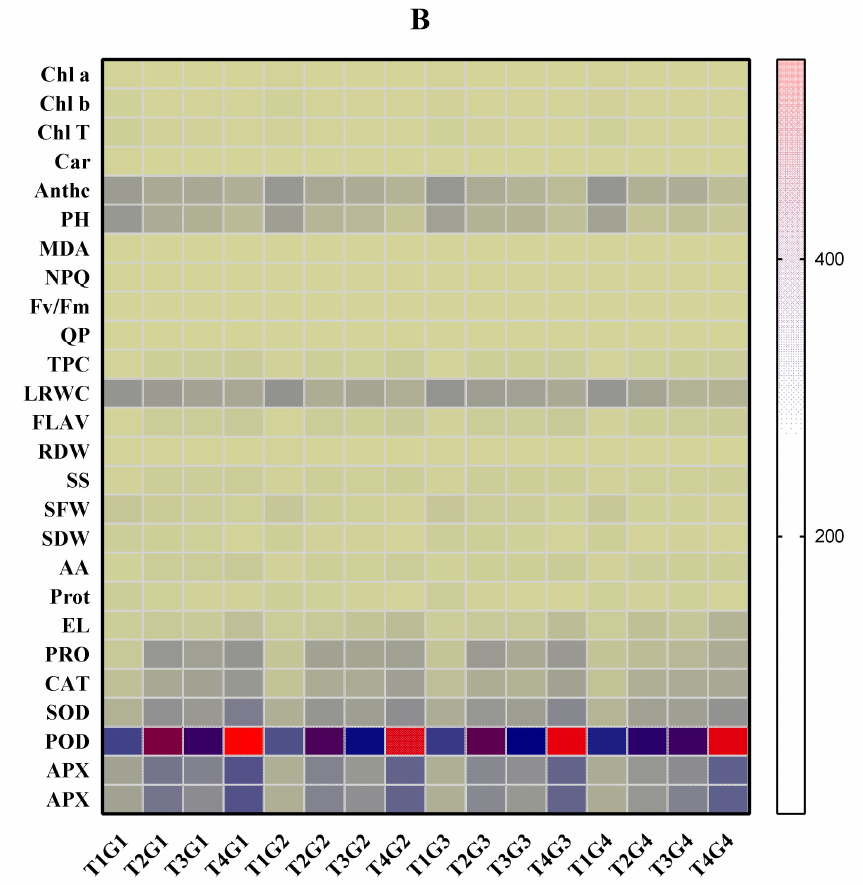
Figure 9. Multivariate statistical analysis indicates associations between treatments, variables, and cultivars. ( A ) Principal component analysis (PCA) based on eco-physiological traits in four soybean cultivars affected by drought, salinity, and combined stress. Blue circles, PI567731; green symbols, PI416937; red symbols, PI567690; and purple symbols, PI408105A in control, drought, salinity, and drought + salinity treatments; ( B ) Heatmap of correlation. T1, control: T2, drought: T3 salinity: T4 drought + salinity; G1, PI567731: G2, PI416937: G3, PI567690: G4, PI408105A. Chl: chlorophyll; Car: carotenoids Chl T: total chlorophyll; PH; plant height; SFW: shoot fresh weight: SDW: shoot dry weight: QP: photochemical quenching; NPQ: non-photochemical quenching; maximal photochemical efficiency (Fv/Fm), RLWC: relative leaf water content; MDA: malondialdehyde; EL: electrolyte leakage; PRO: proline; SS: soluble sugar; CAT: catalase; POD: peroxidase; SOD: superoxide dismutase; APX: ascorbate peroxidase; FLAV: flavonoid content; TPC: total phenolic content; AA: amino